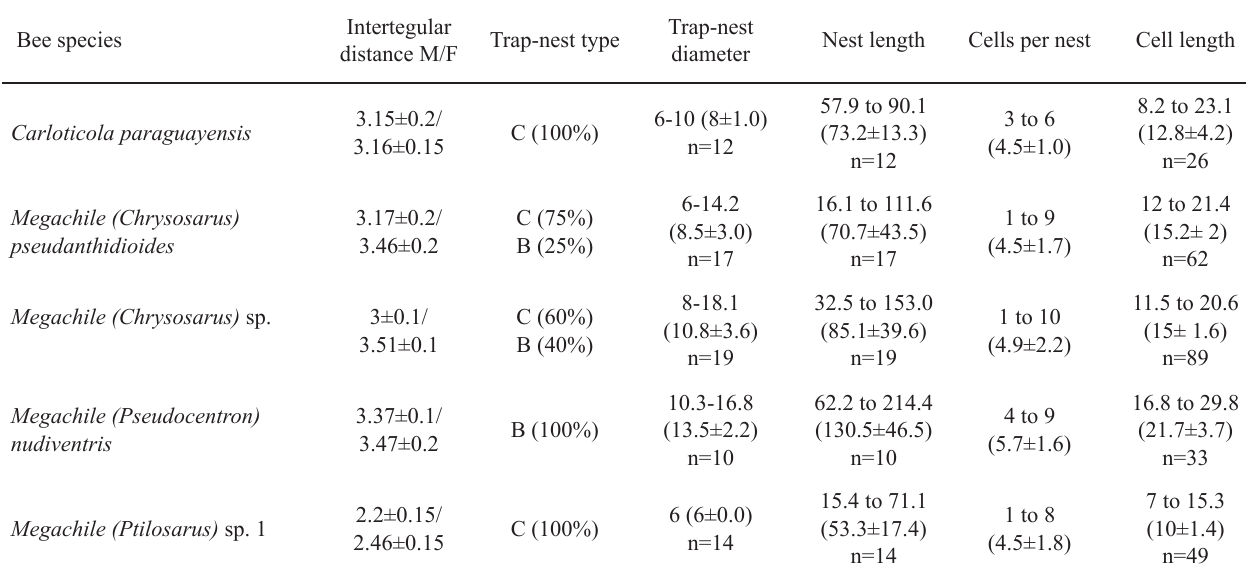
Table 2 . Most abundant Megachilidae species in União Biological Reserve, RJ, Brazil. Intertegular distance was used to compare body size among bees (M=male and F=female). Evaluated attribute of nests: type (C=cardboard; B=bamboo cane) and diameter of occupied trap-nest,